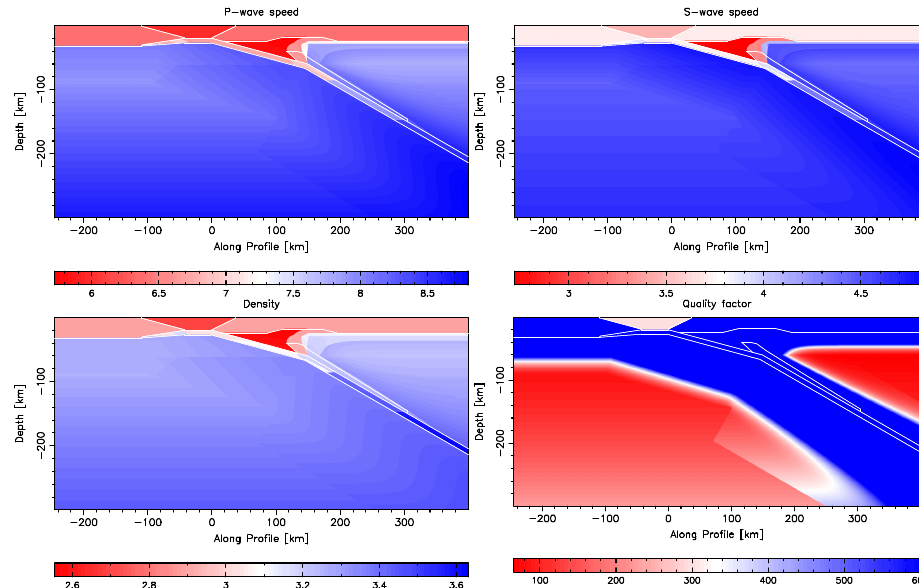
Fig. 4: Distribution of P-wave velocities (top left) and S-velocities (top right) in km/s, density in g / cm 3 (bottom left) and quality factor Q (bottom right), calculated from the temperature model using SLB2005 theory, the phase diagrams of Hacker (2003) and our mineral database which was derived from those of Holland and Powell (1998) and Hacker (2003).